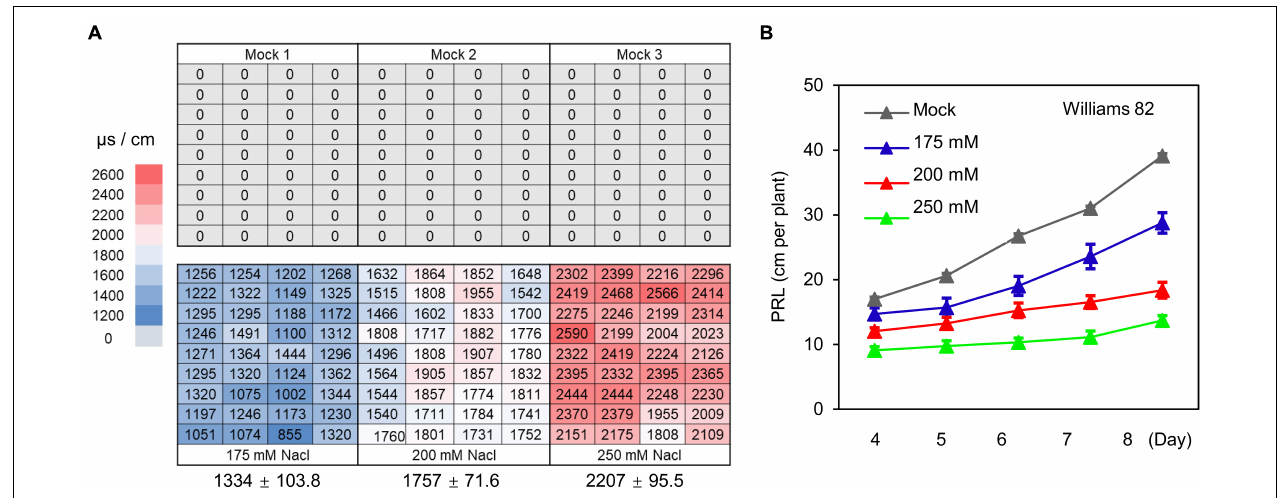
FIGURE 4 | The WinRoots system provides controlled salt stress conditions. (A) Electrical conductivity of surface soil in the WinRoots system (10 days after planting). Each number indicates the electrical conductivity of a sample site within a culture case. The average electrical conductivity ( n = 36) and the standard deviation (SD) are shown below the image. (B) PRL of soybean cultivar Williams 82 under mock and salt stress conditions. Data are shown as mean value ± standard error, n =